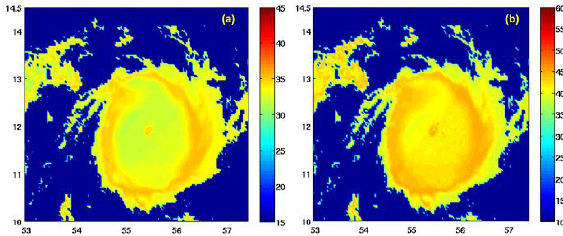
Figure 3. Spatial distribution of CMPs within the TC for 08 November 2015 0600 UTC derived from INSAT-3D. (a) CER and (b) COT.